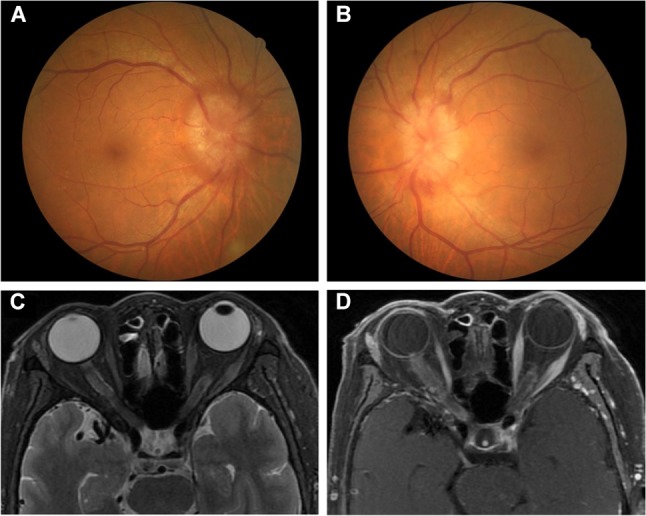
(A,B) Fundus examination in Case 2. Bilateral optic disc oedema. (C,D) Orbital MRI in Case 2. (C) Bilateral optic nerve enlargements of orbital and inner canal segments in T2-weight imaging. (D) Bilateral leptomeningeal enhancement in optic nerves when gadolinium was administered (“tram-tracking” sign).